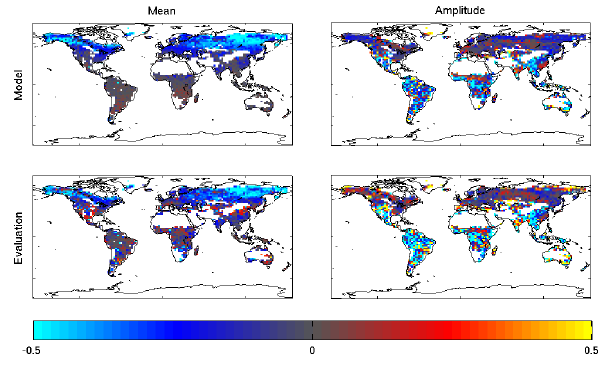
Fig. 5. Relative model bias in mean LAI (left) and seasonal am- plitude (right) for the model training period 2001–2005 (top) and evaluation period 2006 (bottom).